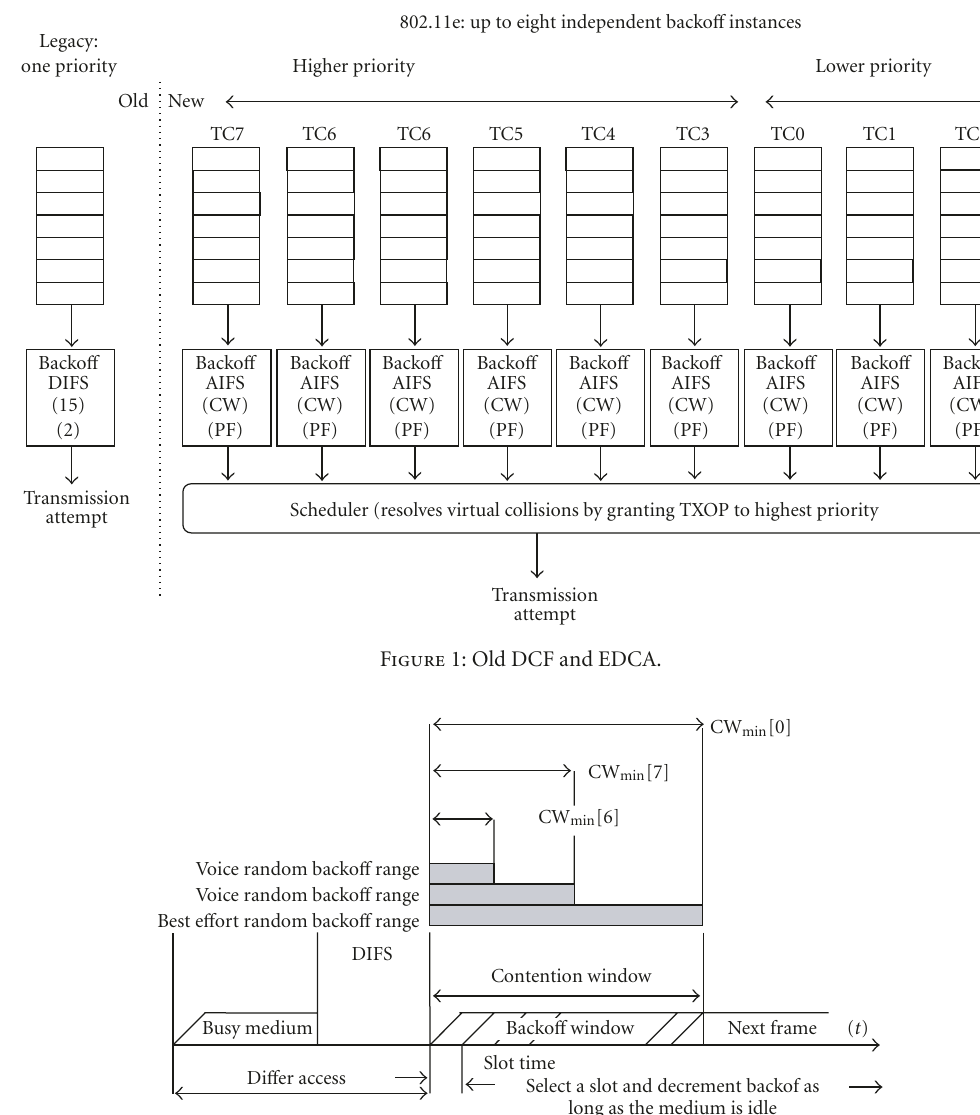
Figure 2: Di ff erent AIFS for di ff erent